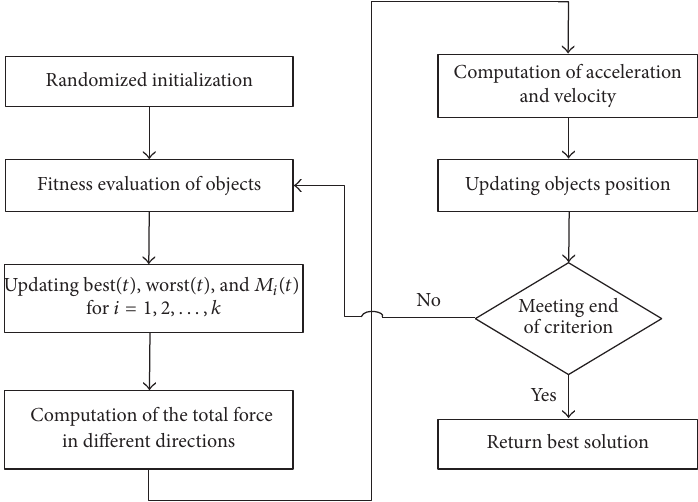
Figure 1: Flowchart of gravitational search